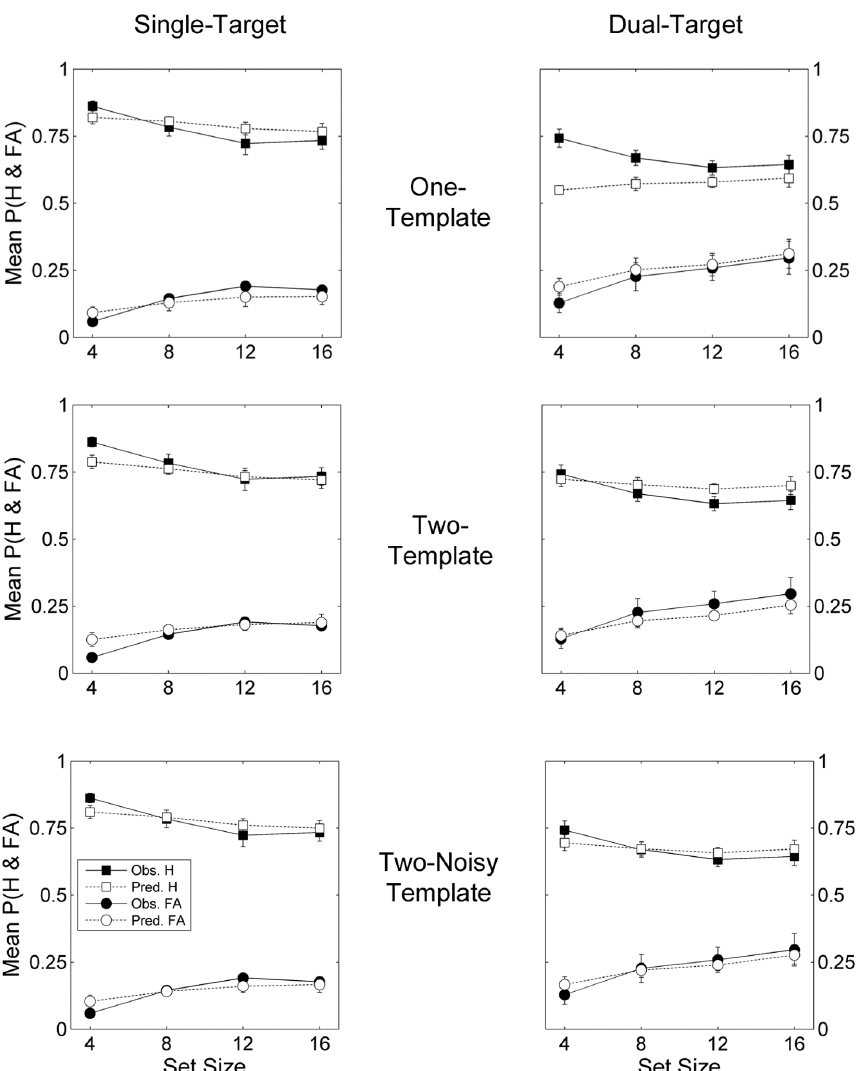
Figure 2. Observed (black symbols) and predicted (white symbols) accuracy by search type and set size for each model. Square symbols represent mean hit rates and circles represent mean false alarm rates. Error bars denote standard errors of the means.